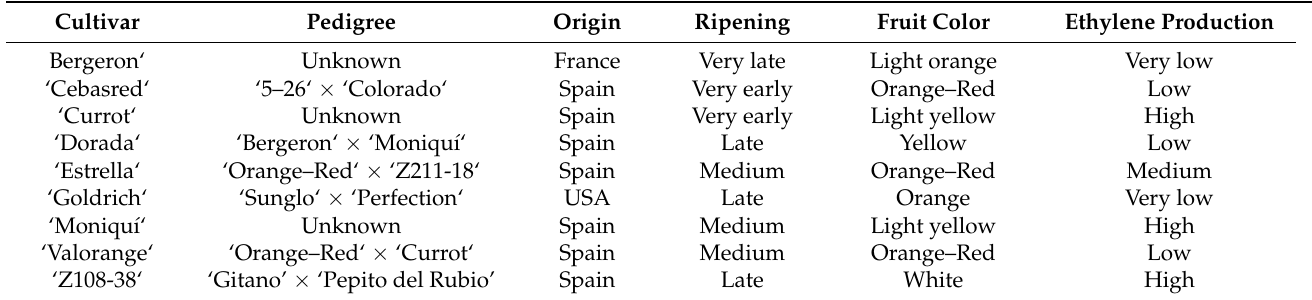
Table 2. Apricot cultivars